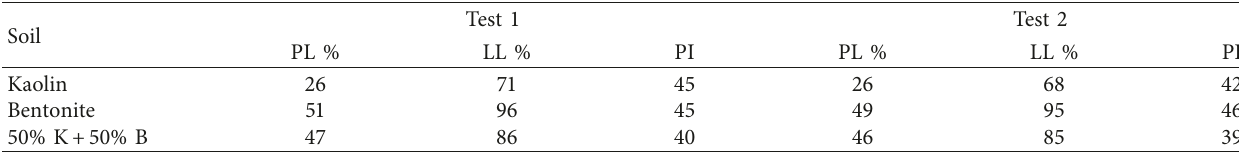
Table 1: Plastic limits and liquid limits obtained from fall cone tests.